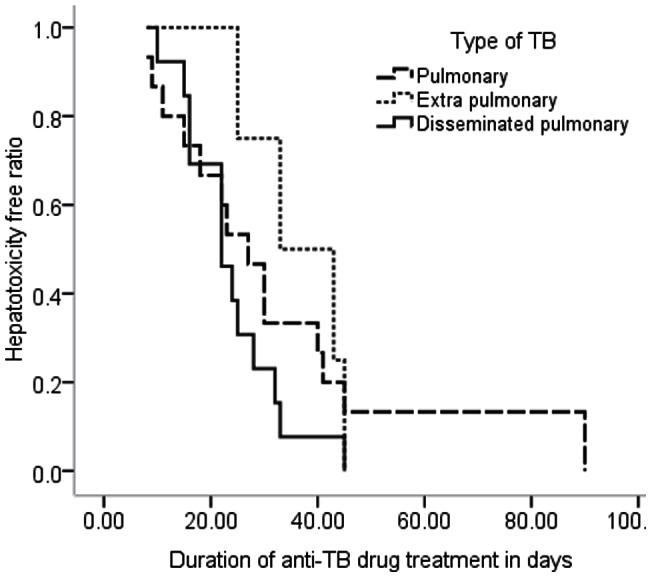
Duration of patients stay on anti-TB drugs before the occurrence of hepatotoxicity by the type of TB.